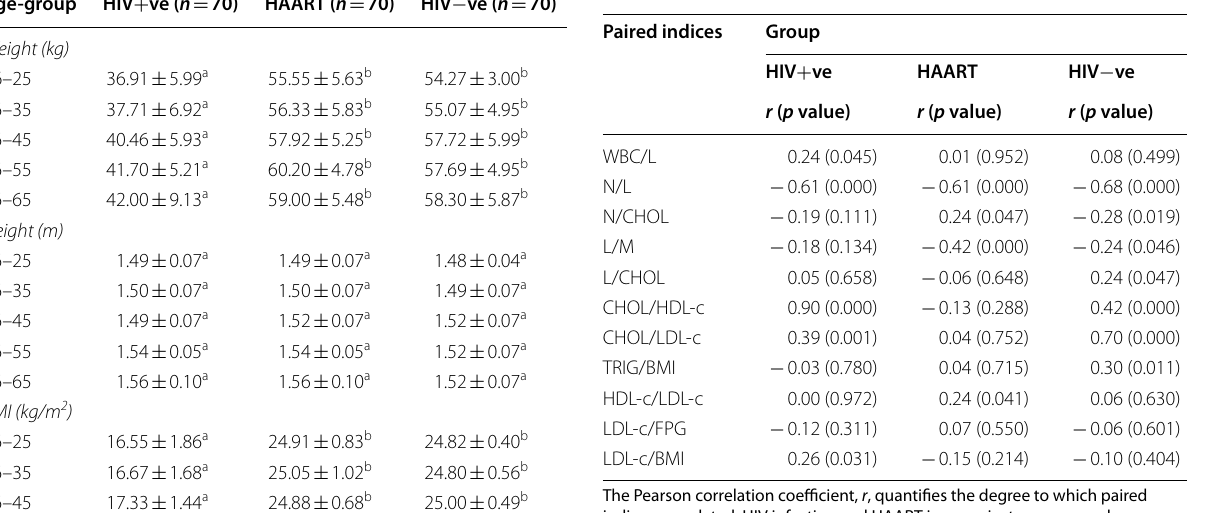
Table 4 Comparison of hematological, biochemical and anthropometric indicators among HIV-positive patients without treatment, HIV-positive patients on HAART, and people without HIV